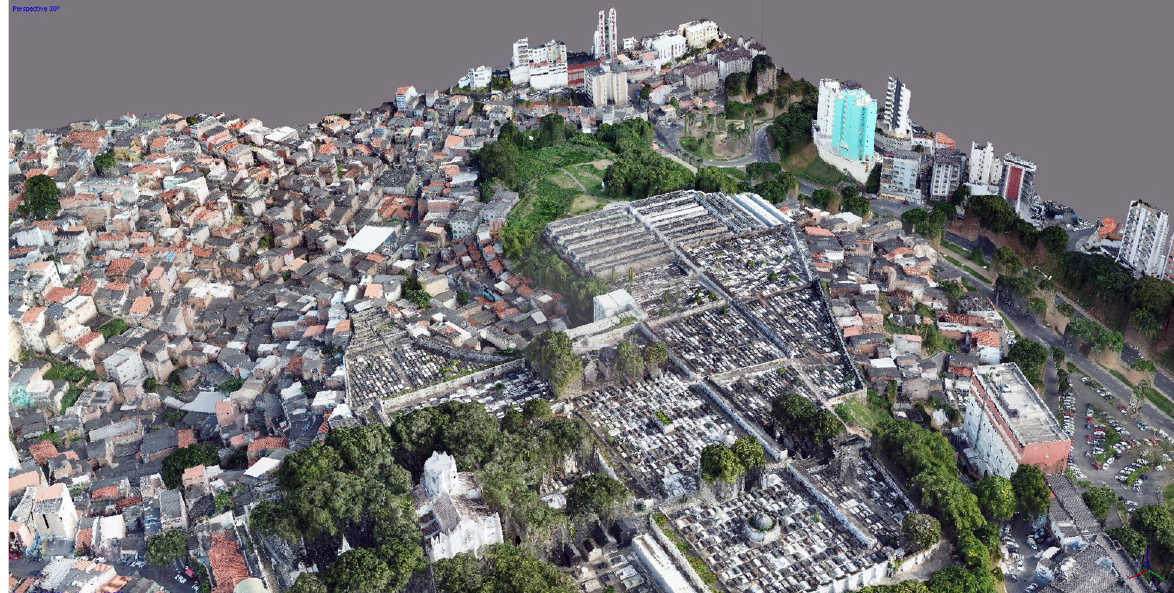
Fig. 3. 3D model of the study generated by drone: Alto das Pombas